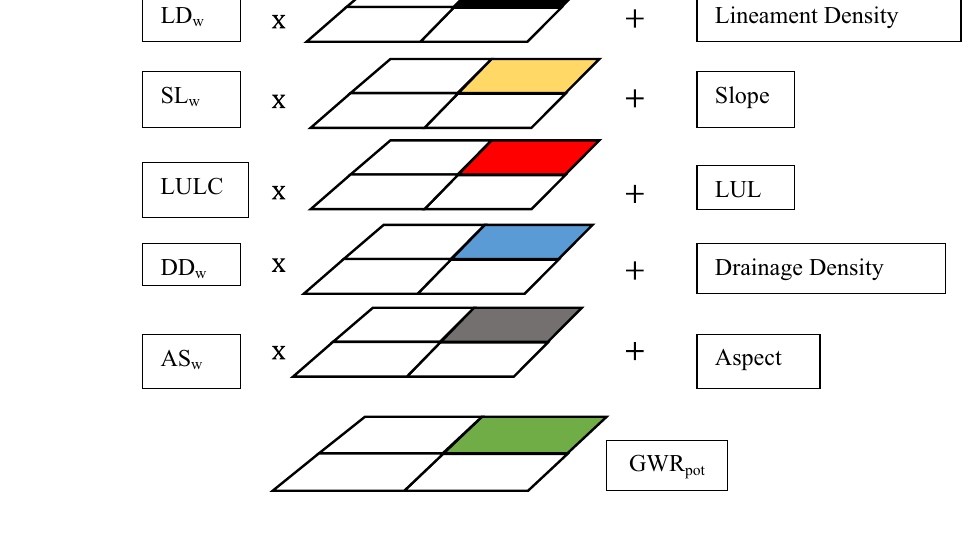
Fig. 4 Suggested interrela- tionship between the multi influencing factors on the groundwater recharge poten- tial